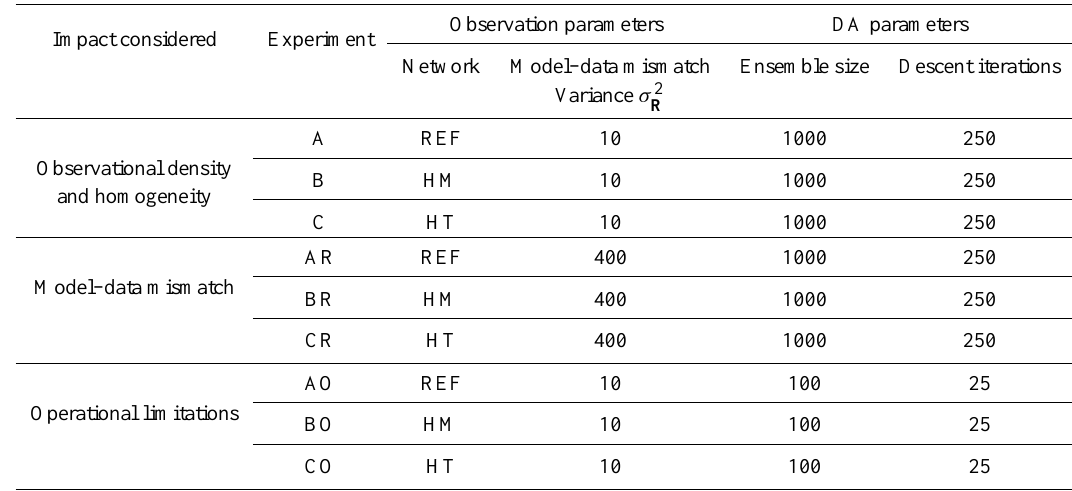
Table 1. Summary of the experiments outlined in Sect. 2.3. The following parameters are held constant for all the experiments in this